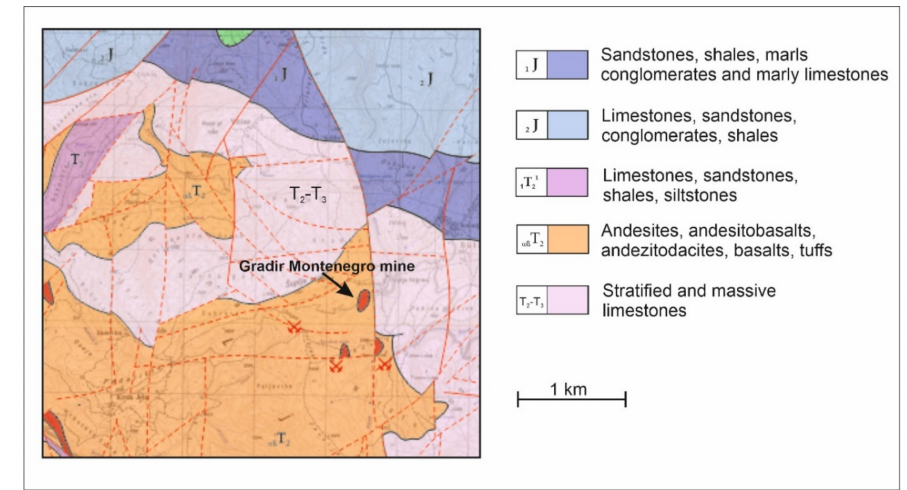
Figure 1. Geological map of the exploration area with a marked Gradir Montenegro mine